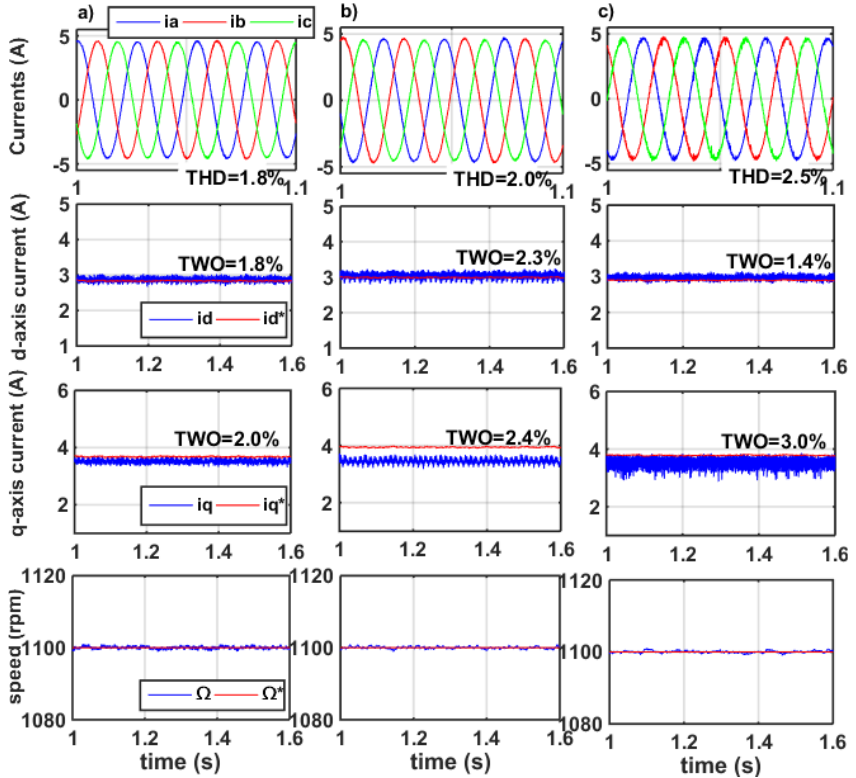
Figure 6. Experimental results for 1100 rpm and 5 Nm: ( a ) MBPCC with nominal parameters, ( b ) MBPCC under the influence of parameter variations (0.5xLd, 0.5xLq), ( c ) proposed GW − MFPCC. In terms of rotor speed performance, all control strategies are relatively similar. In terms of three ‐ phase currents steady ‐ state performance, the GW ‐ MFPCC performs very similarly to the MBPCC with optimal parameters, albeit with a small difference in THD values. The GW ‐ MFPCC outperforms the MBPCC in aspects of d ‐ axis current and offers marginally lower q ‐ axis current performance to the MBPCC with optimal parameters, showing a slight difference in TWO value, as well as perfect reference tracking capabilities. However, because the MBPCC is very sensitive to parameter variations, it can be observed an obvious offset between the actual and reference q ‐ axis current when mismatched inductances are considered, resulting in poor tracking capability performance. It can be also seen that the d ‐ axis current presents higher ripple content than the one corresponding to the other control techniques. Therefore, the experimental results confirm the effectiveness of the proposed GW ‐ MFPCC in suppressing the influence of parameters variations in SynRM. Another steady ‐ state experimental test is carried out, and the three ‐ phase currents, d ‐ axis current, q ‐ axis current, and rotor speed, are shown in Figure 7 at 800 rpm and 14 Nm load torque.